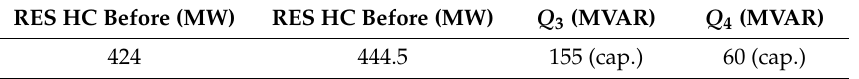
Table 11. RES reactive power control effects on the increasing of the RES hosting capacity.